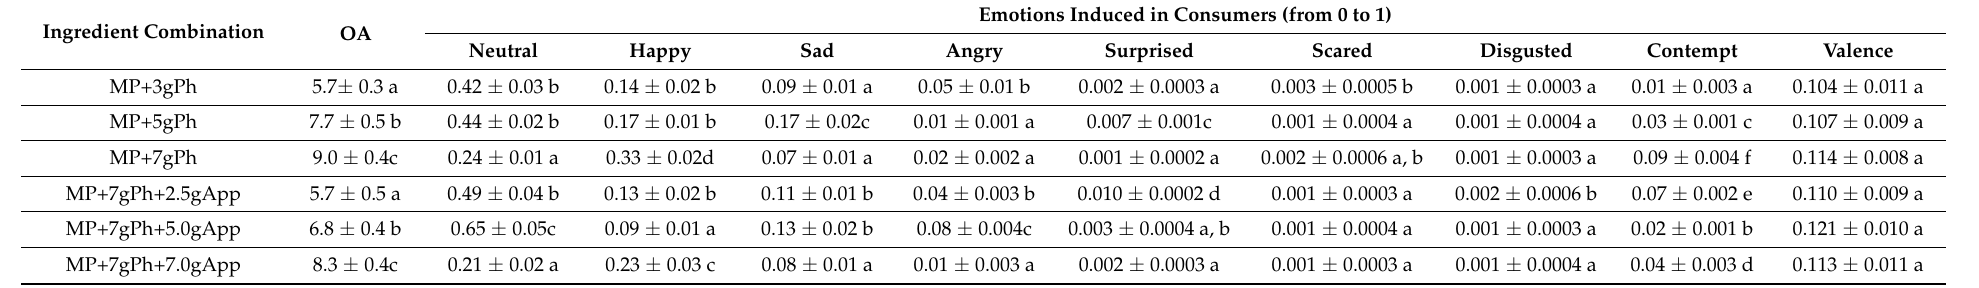
Table 2. Overall acceptability (OA) and emotions (EMs) induced in consumers by the prepared fermented milk permeate (MP), psyllium husk (Ph), and apple by-product combinations. Ingredient Combination